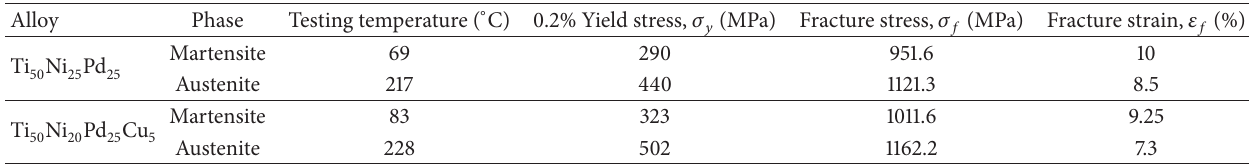
Table 2: Yield stress, fracture stress, and fracture strain calculated from stress-strain curves of Figures 2 and 3 for Ti Ni Pd Cu Ti 50 20 25 5